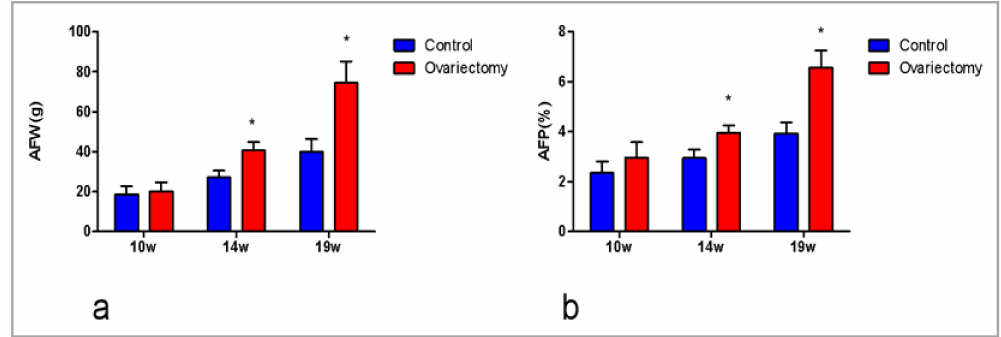
Figure 1. Abdominal fat weight (AFW) and abdominal fat percent (AFP) increase in the abdominal fat (AF) of female chickens after ovariectomy. AFW was increased in the AF of female chickens at 14 and 19 weeks after ovariectomy ( a ). AFP was increased in the AF of female chickens at 14 and 19 weeks after ovariectomy ( b ). Data are presented as means ± SEM ( n = 20; * p <